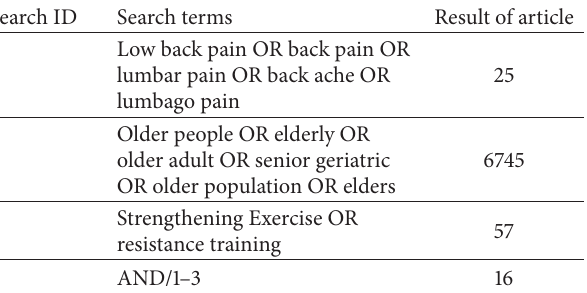
Table 1: Example of literature searching using EBSCO EconLit 2006–2016 search